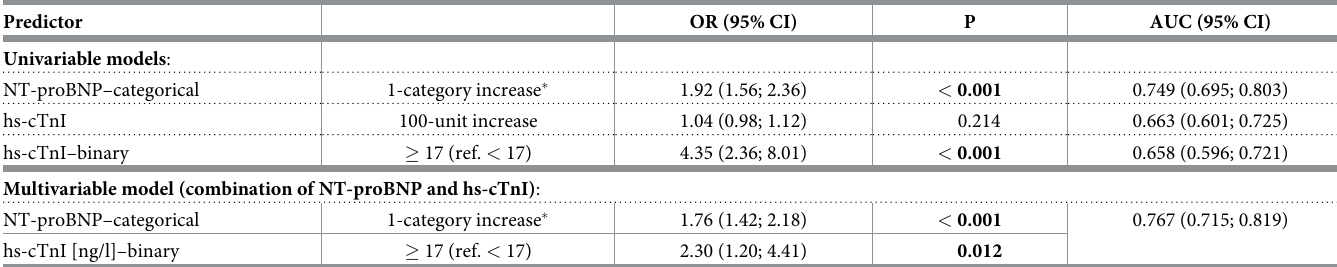
Table 2. NT-proBNP [ng/l] and hs-cTnI [ng/l] as predictors of the primary endpoint in the logistic regression models (i.e., the two-year prognosis in terms of all- cause mortality, heart transplantation and left ventricular assist device [LVAD] implantation).